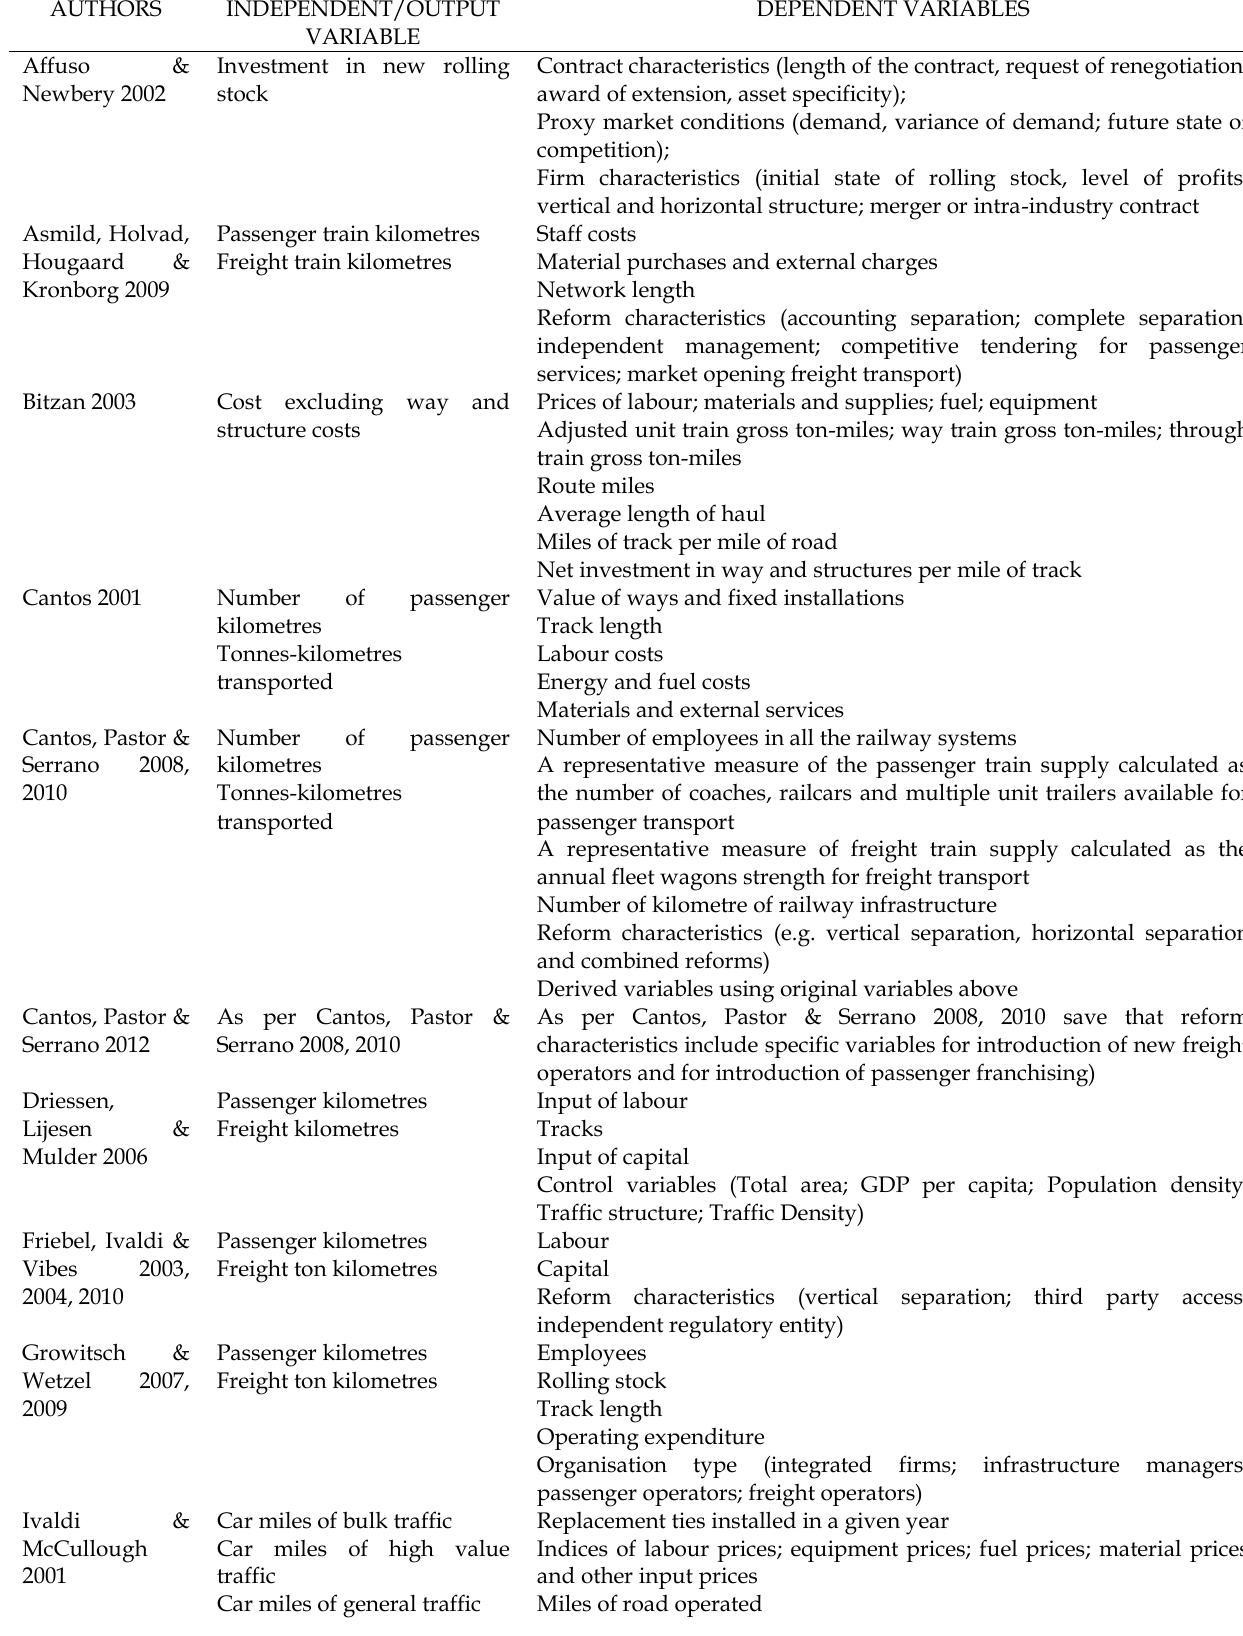
Table A2. Summary of studies on rail vertical integration – variables used